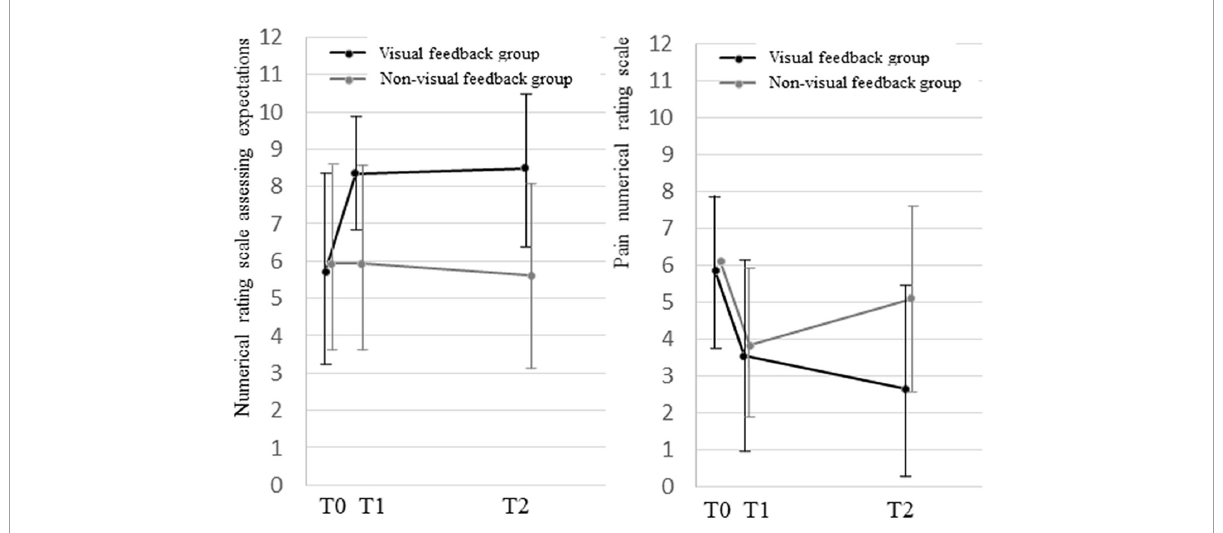
FIGURE2 Path diagram for the hypothetical model. NRS, numerical rating